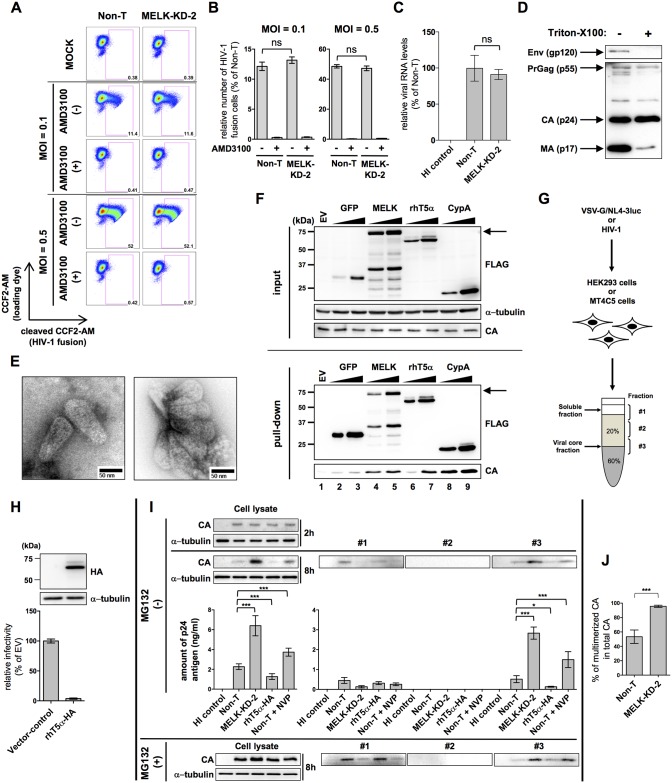
Depletion of MELK delays HIV-1 CA disassembly.(A) Non-T or MELK-KD-2 MT4C5 cells were mock-infected or infected with 100 or 500 ng of p24-measured amounts of NL4-3 virions containing BlaM-Vpr, based on the measured amount of p24, in the presence or absence of AMD3100 (100 nM). They were then analyzed in the fusion assay by flow cytometry using a violet laser to excite CCF2. Each experiment was performed in triplicate, repeated three times and one set of representative data is shown. (B) Relative numbers of BlaM+ MELK-KD-2 MT4C5 cells are shown as percentages (%) of Non-T MT4C5 cells with standard deviations calculated from three independent experiments. (C) Virion-associated viral RNA was quantified by quantitative RT-PCR 2 h after infection of Non-T or MELK-KD-2 MT4C5 cells with wild-type HIV-1. Error bars indicate the standard deviations calculated from five independent experiments. (D) Immunoblot analysis of envelope-stripped HIV-1 cores. Concentrated virions were subjected to step-gradient centrifugation in the absence (-) or presence (+) of 0.1% of Triton-X100. (E) Electron micrographs showing envelope-stripped cores of HIV-1. TEM images of a negatively stained envelope-stripped core of HIV-1 prepared from HIV-1NL4-3 virions. Bars indicate 50 nm. (F) Immunoblot analyses showing MELK bound to envelope-stripped cores of HIV-1. HeLa cells were transfected with pCAG-OSF (lane 1) or increasing amounts of pCAG-OSF-GFP (lanes 2 to 3), pCAG-OSF-MELK (lanes 4 to 5), pCAG-FOS2-rhT5α (lanes 6 to 7) or pCAG-OSF-CypA (lanes 8 to 9). Purified OSF- or FOS2-tagged proteins were incubated with envelope-stripped cores and complex formation was assessed. Masses of molecular weight standards are indicated on the left. Arrows indicate the position of MELK in the gel. (G) Schematic diagram of the fate-of-capsid assay. (H) Forced expression of rhesus Trim5α (rhT5α) inhibits HIV-1 replication in human T cells. Cell lysates were prepared from MT4C5 cells transduced with empty lentivirus (vector-control) or lentivirus for C-terminally HA-tagged rhesus Trim5α expression (rhT5α-HA) and processed for immunoblotting with anti-HA (HA) and anti-alpha-tubulin (α-tubulin) antibodies. Experiments were performed at least three times and one representative set of data is shown (upper panels). Vector-control and rhT5α-HA cells were infected with VSV-G-env-pseudotyped NL4-3luc. Relative luciferase activity is shown as a percentage (%) of the RLU of vector-control cells with standard deviations calculated from five independent experiments (lower panel). (I) Effect of MELK depletion on the fate of the HIV-1 CA in MT4C5 cells. Non-T, MELK-KD-2, MT4C5 cells expressing rhT5α (rhT5α), or Non-T cells treated with 10 μM nevirapine (Non-T + NVP) were infected with wild-type HIV-1 for 8 h in the presence or absence of 10 μM MG132 (MG132 [+] or MG132 [–]). HIV-1 stock inactivated by incubation at 65°C for 30 min was used as a negative control (HI control). Cell lysates were subjected to 20%–60% step-gradient centrifugation and three fractions were collected from the top (fraction #1), middle (fraction #2) and interface between the 20% and 60% sucrose layers (fraction #3). Aliquots of each fraction were processed for immunoblotting with anti-p24 antibody (CA) (upper panel). Experiments were performed at least five times and one representative set of data is shown. The amount of CA in each fraction in the absence of MG132 was quantified by HIV-1 p24 ELISA (lower panel). Error bars indicate the standard deviations calculated from five independent experiments. (J) Percentage of the pelletable CA (fraction #3) within total CA in the absence of MG132 was calculated based on the p24 ELISA data shown in Fig 2H. Total CA denotes the sum of the amount of p24 antigen which was calculated based on the p24 ELISA data of fractions #1, #2, and #3. Error bars represent the standard deviations calculated from five independent experiments. Statistical significance was determined by unpaired two-tailed Student’s t test (B, C, H and J), or one-way analysis of variance (ANOVA) with Dunnett’s multiple comparison test (I). ns, not significant (P>0.05); *P<0.05, **P<0.01, ***P<0.001.